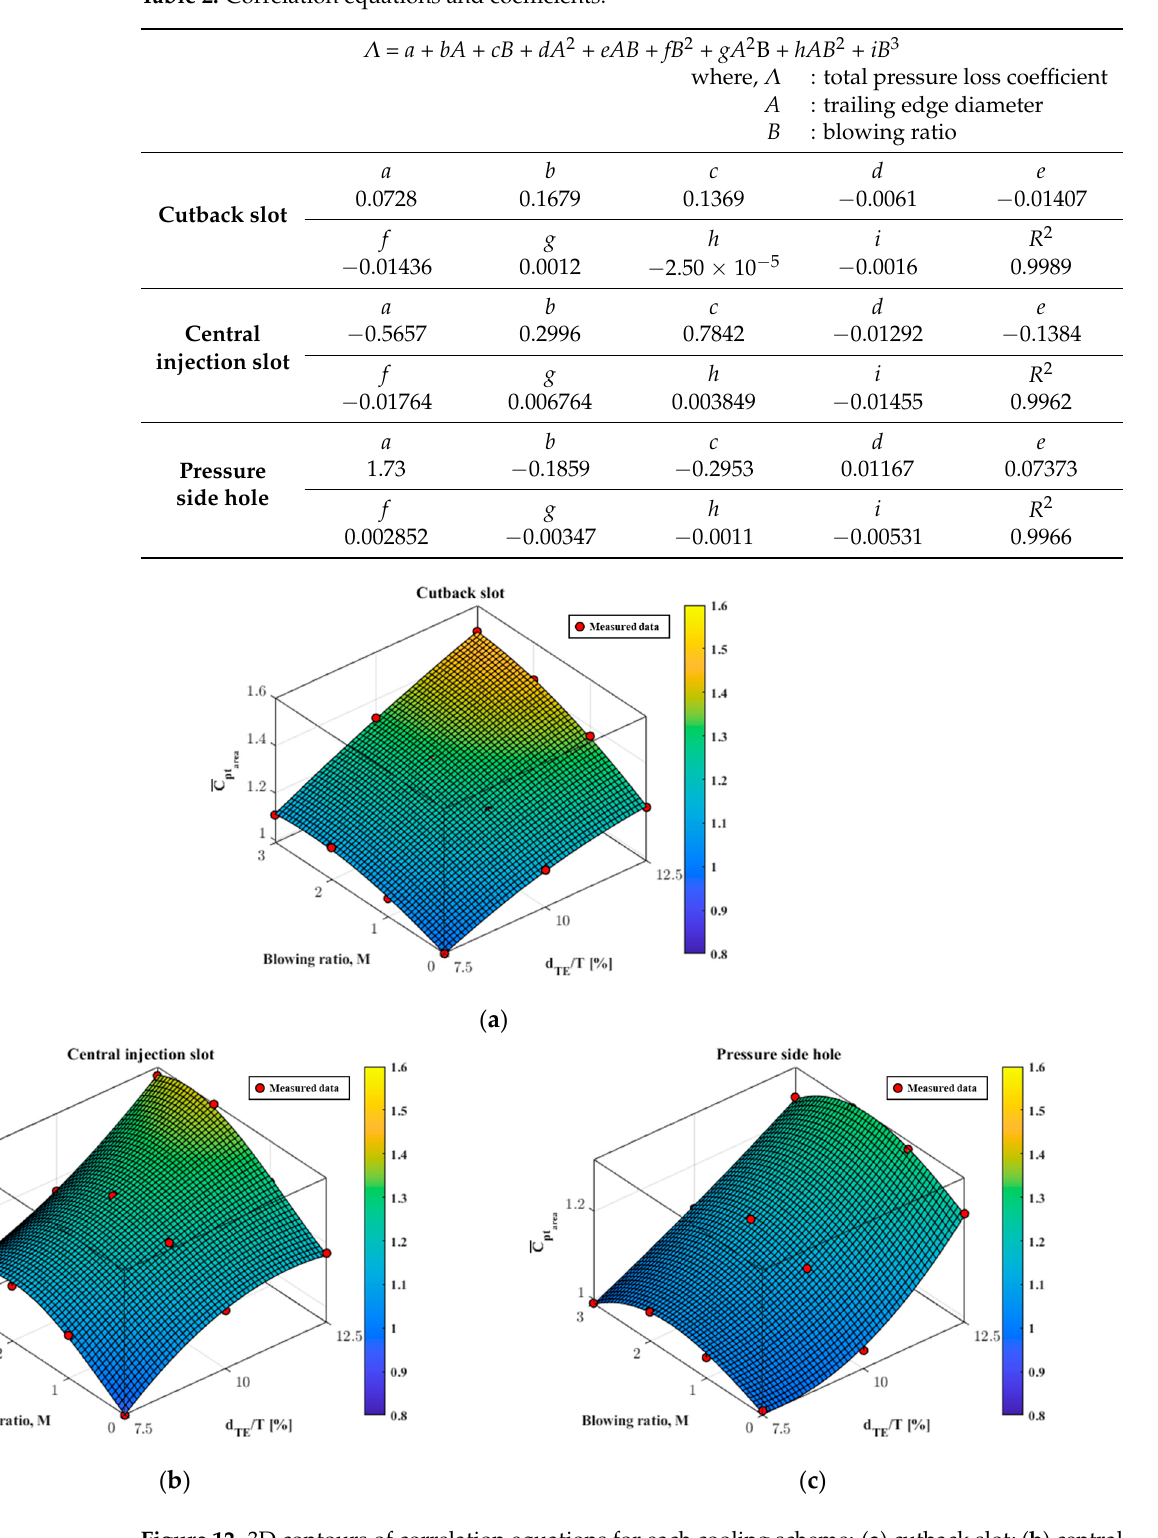
Table 2. Correlation equations and coefficients.